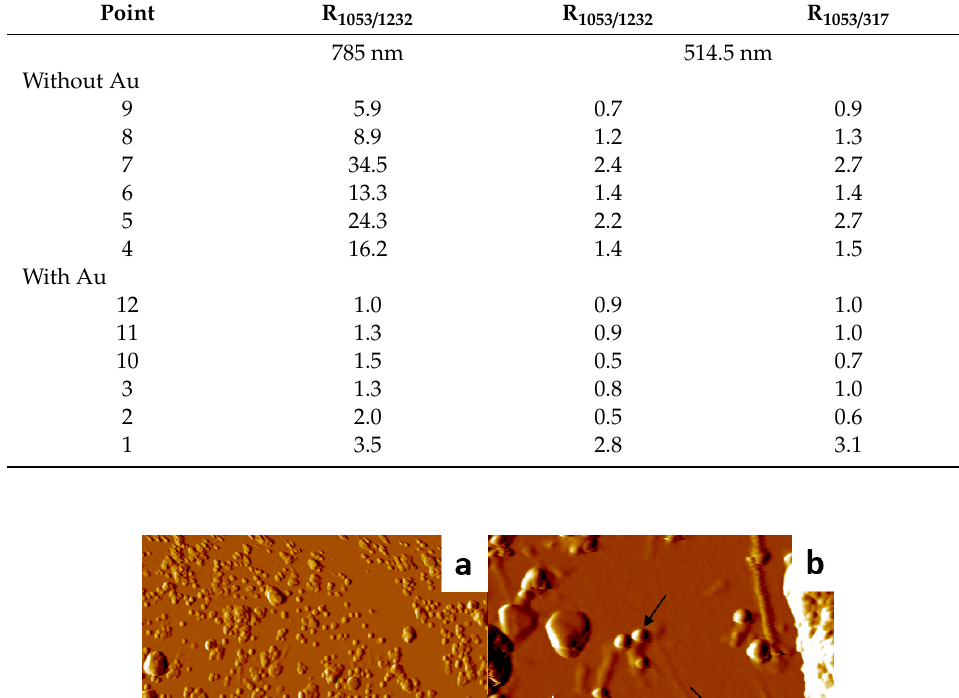
Table 1. Comparison of the intensity ratio (R) of the 1053 cm − 1 NO 3 − band and the 317 and 1232 cm − 1 bands of the J-aggregates obtained with 785 and 514.5 nm excitation.